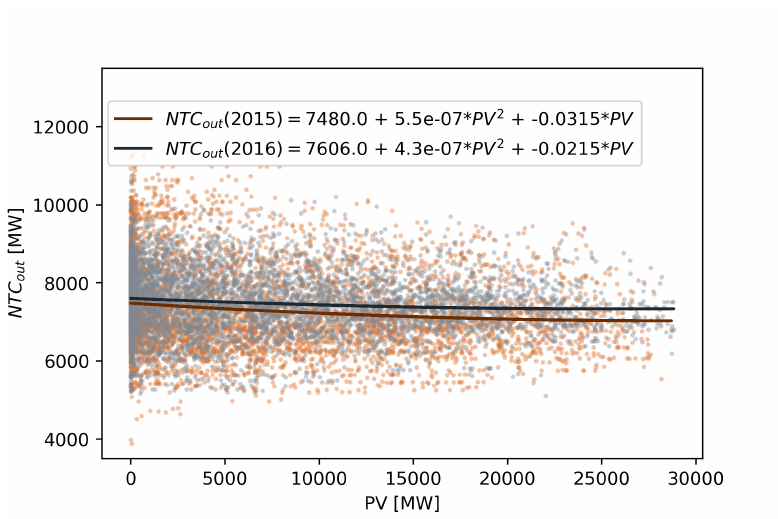
Figure 10. Relation between available export net transfer capacity (2015 and 2016) and PV